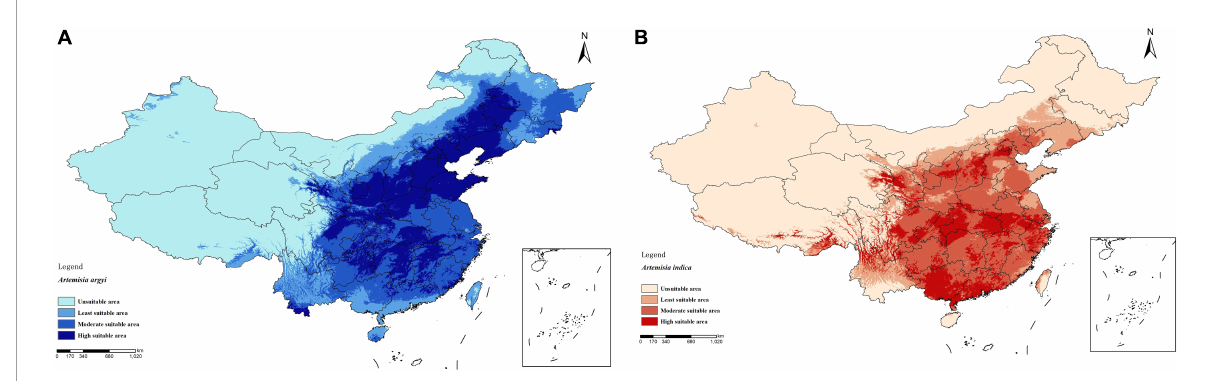
FIGURE2 Distribution of A. argyi and A. indica . Darker color means more suitable for growth. Distribution of A. argyi (A) and A. indica (B) in China. A. argyi is mainly distributed in the eastern coastal areas, and A. indica is mainly distributed in the southeastern coastal areas.